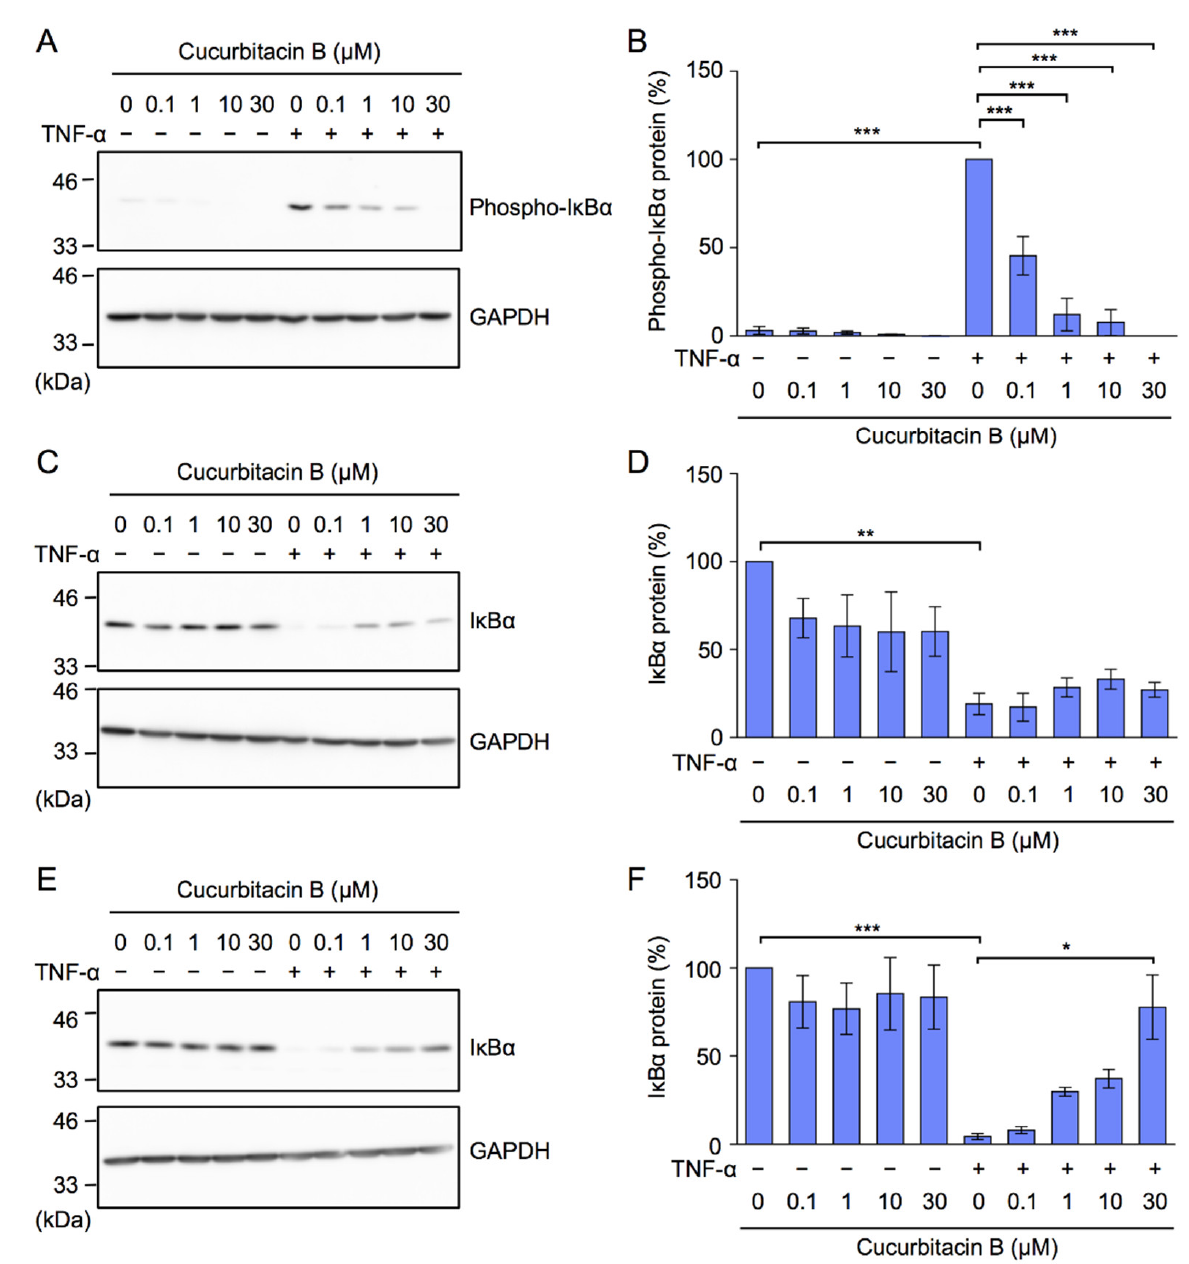
Figure 4. Cucurbitacin B inhibited TNF- α -induced I κ B α phosphorylation and its subsequent degra- dation. ( A – F ) A549 cells were pretreated with or without cucurbitacin B for 1 h and were then treated with (+) or without ( − ) TNF- α (2.5 ng/mL) for 5 min ( A – D ) and 15 min ( E , F ) in the presence or absence of cucurbitacin B at the indicated final concentrations, followed by the preparation of cytoplasmic fractions. Western blots are representative of three independent experiments ( A , C , F ). The amounts of phospho-I κ B α and I κ B α were normalized to that of GAPDH. Phospho-I κ B α protein (%) and I κ B α protein (%) are shown as the mean ± S.E. of three independent experiments ( B , D , F ). * p < 0.05, ** p < 0.01 and *** p <